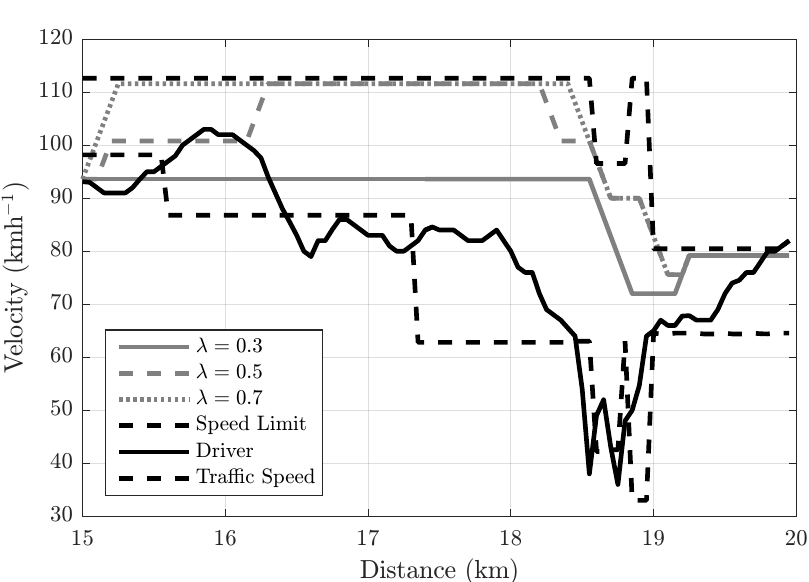
Figure 7. Speed limit-constrained velocity profiles from driver data (solid black) and DP optimal velocity (solid grey λ = 0.3, dashed grey, λ = 0.5 and dotted grey, λ = 0.7) with the speed limit upper velocity constraint. Legal speed limit and real-time traffic shown as the dashed black line, upper and lower,